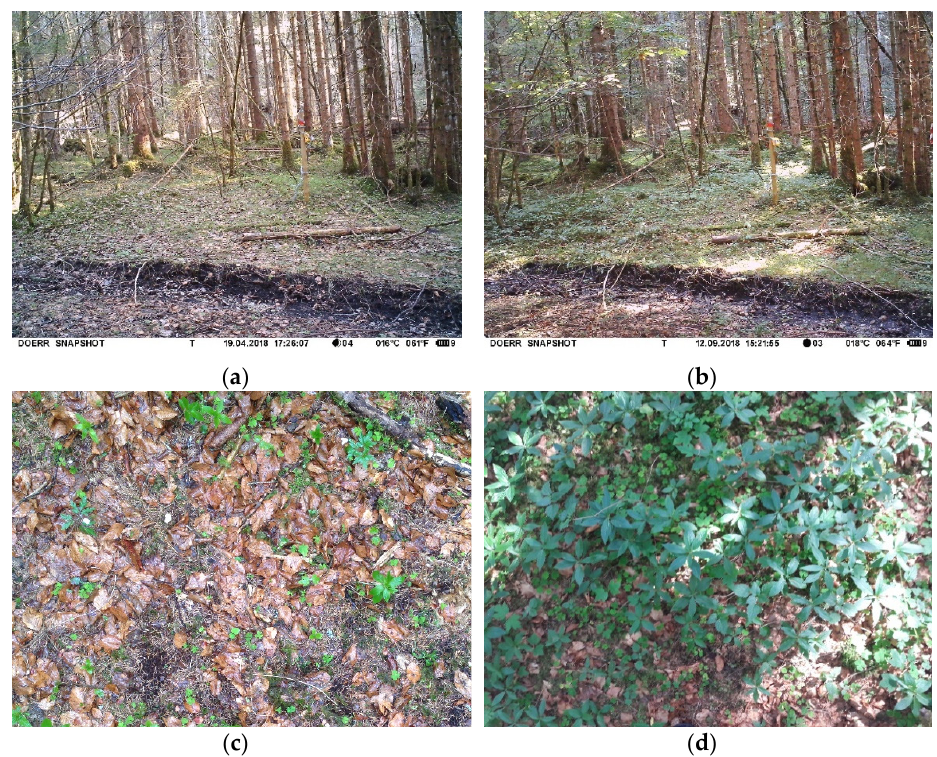
Figure A1. Photos of the forest stand with ( a ) the PAR sensor and ( b ) understory vegetation at the spring, as well as ( c ) the PAR sensor and ( d ) understory vegetation at the summer acquisition date.